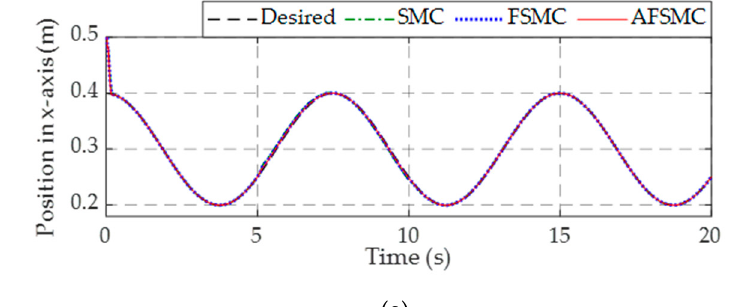
Figure 16. The tracking performance of the three joints: ( a ) The first joint and ( b ) its error; ( c ) the second joint and ( d ) its error; ( e ) the third joint and ( f ) its error in comparison between SMC and FSMC with AFSMC.